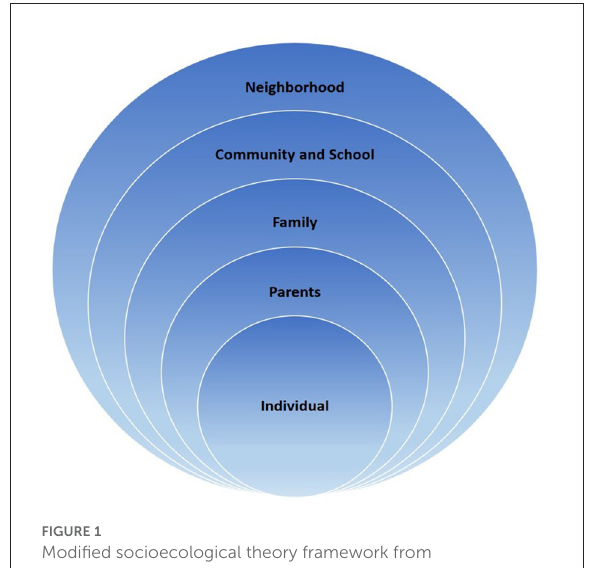
FIGURE1 Modified socioecological theory framework from Bronfenbrenner